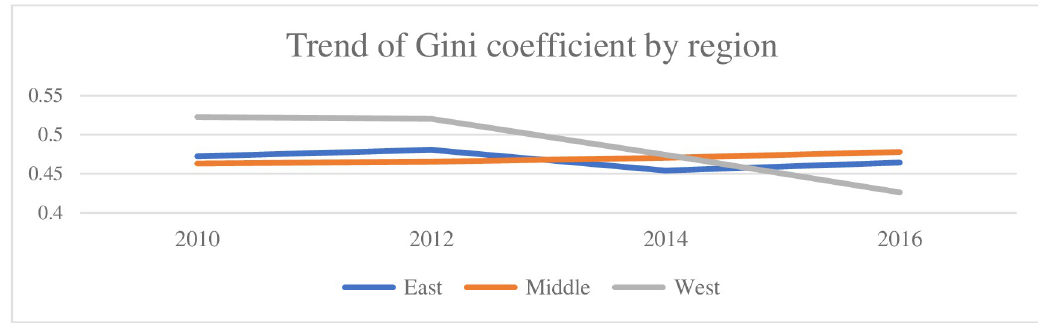
Fig 4. The trend of Gini coefficient in east, middle and west regions. Source: CFPS 2010–2016 database.